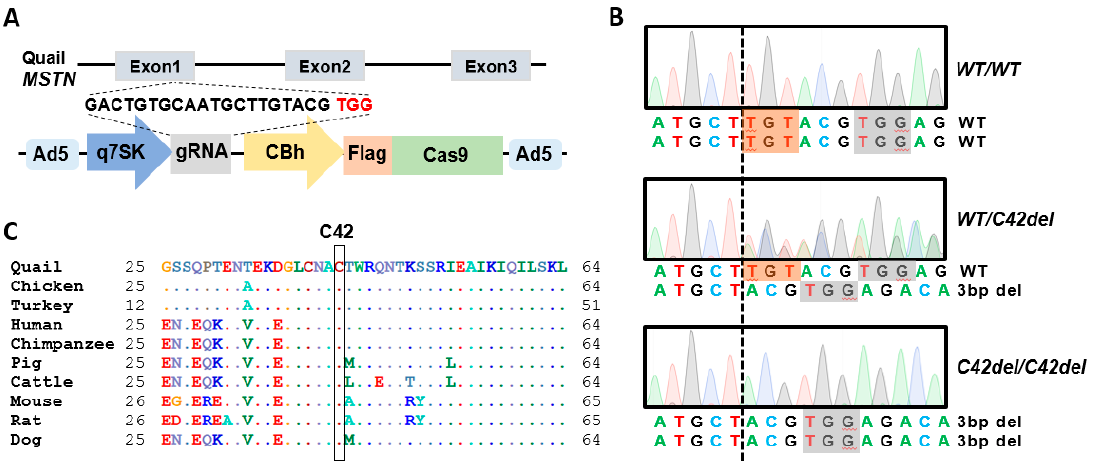
Figure 1. Generation of myostatin ( MSTN) mutation in quail using adenovirus. ( A ) To target quail MSTN , guide RNA (gRNA) was designated on exon 1 and expression of gRNA and Cas9 was regulated by a quail 7SK promoter and a CBh promoter, respectively, in the adenoviral CRISRP / Cas9 vector. ( B ) Sanger sequencing chromatograms of a targeted region in the MSTN gene of wild-type ( WT / WT ), MSTN heterozygous mutant ( WT / C42del ), and MSTN homozygous mutant ( C42del / C42del ) quail were compared. Dashed line indicates the point where three base-pair deletion occurs and nucleotides that will be deleted in mutant allele are highlighted in red. Protospacer adjacent motif is highlighted in gray. ( C ) Amino acid sequences of MSTN protein after signal peptide are compared across species. Dots represent identical amino acids to quail MSTN protein. Black box indicates conserved cysteine 42 residue that is deleted by MSTN mutation in quail.